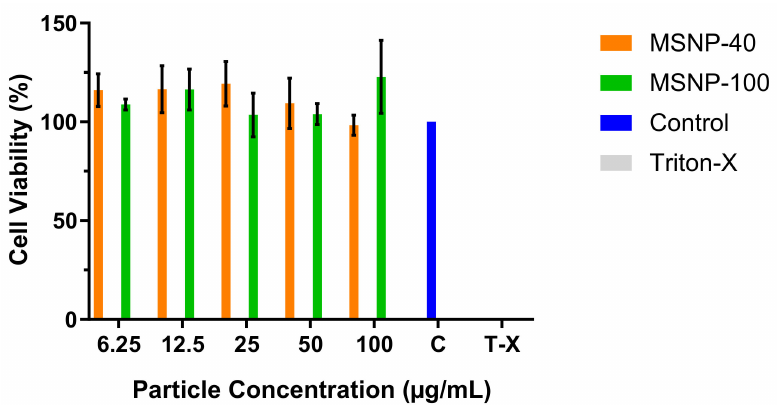
Figure 3. Cellular viability as determined via MTT assay (mean ± SD, n = 3).